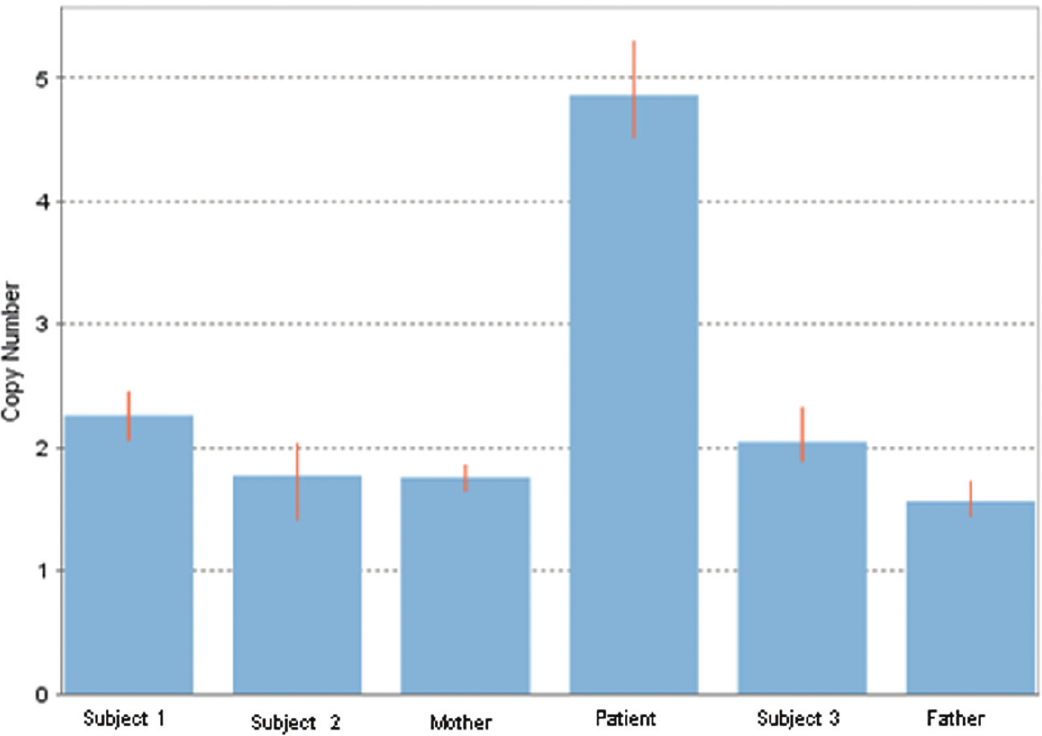
Figure 2 - Assessment of MSX2 copy number variation. The estimated copy number variations for the patient, the progenitors, and three unrelated subjects are presented. The bars represent the variation in the calculated copy number. The values were ¡ 0.41 for Subject 1, ¡ 0.63 for Subject 2, ¡ 0.23 for the patient’s mother, ¡ 0.79 for the patient, ¡ 0.45 for Subject 3 and ¡ 0.30 for the patient’s